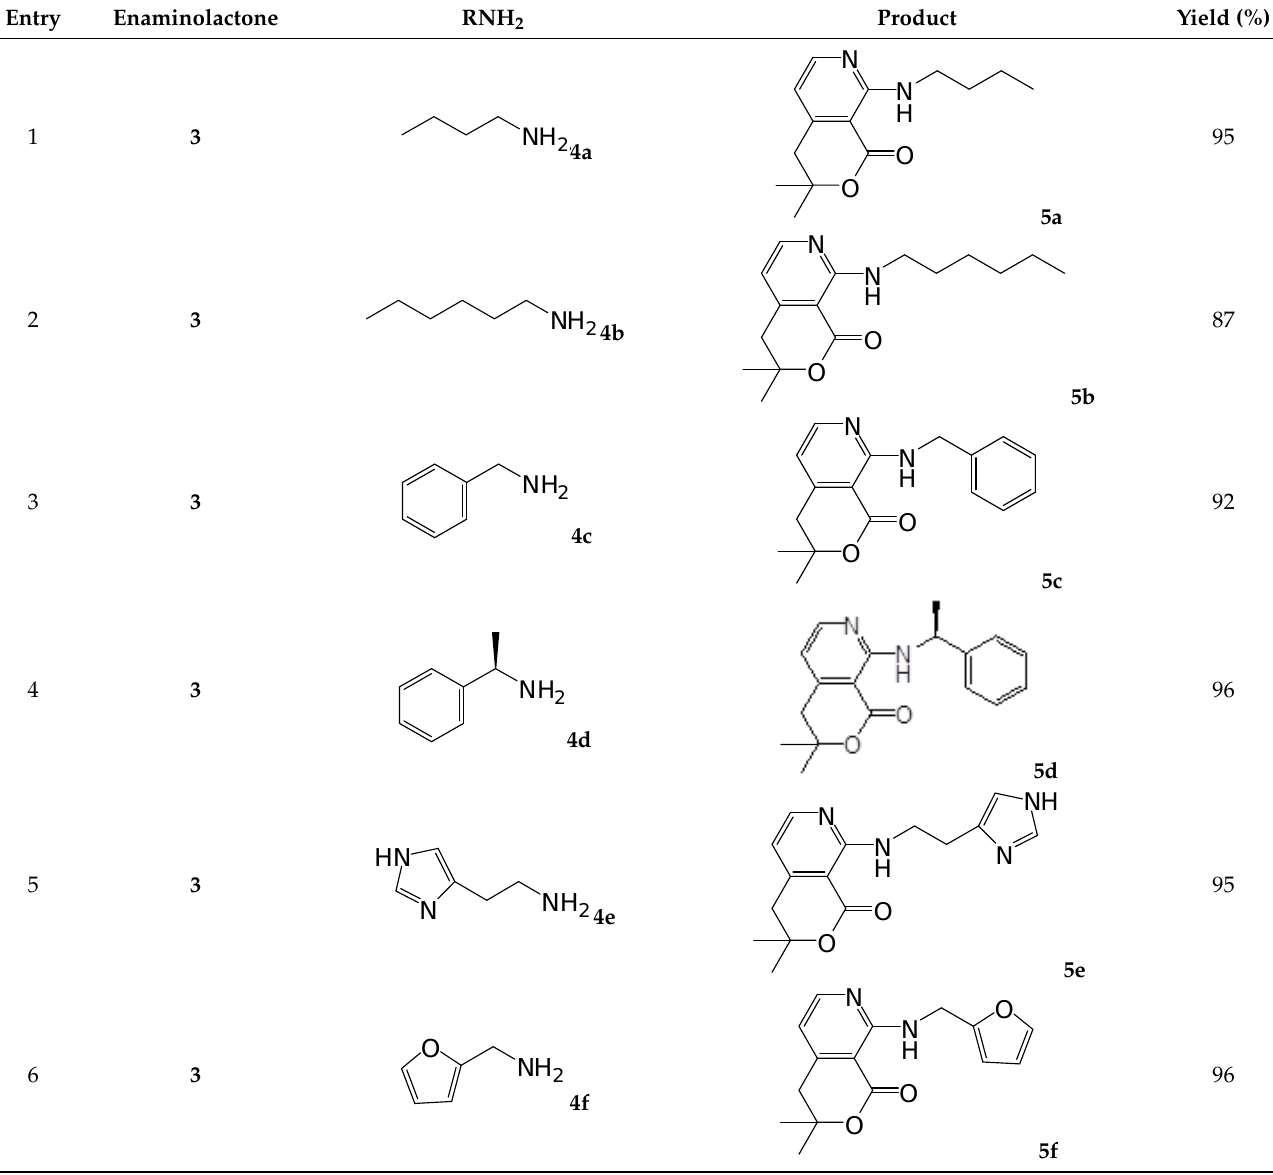
Figure 4. Synthesis of new bis-(2-aminopyridines) 7a – c.